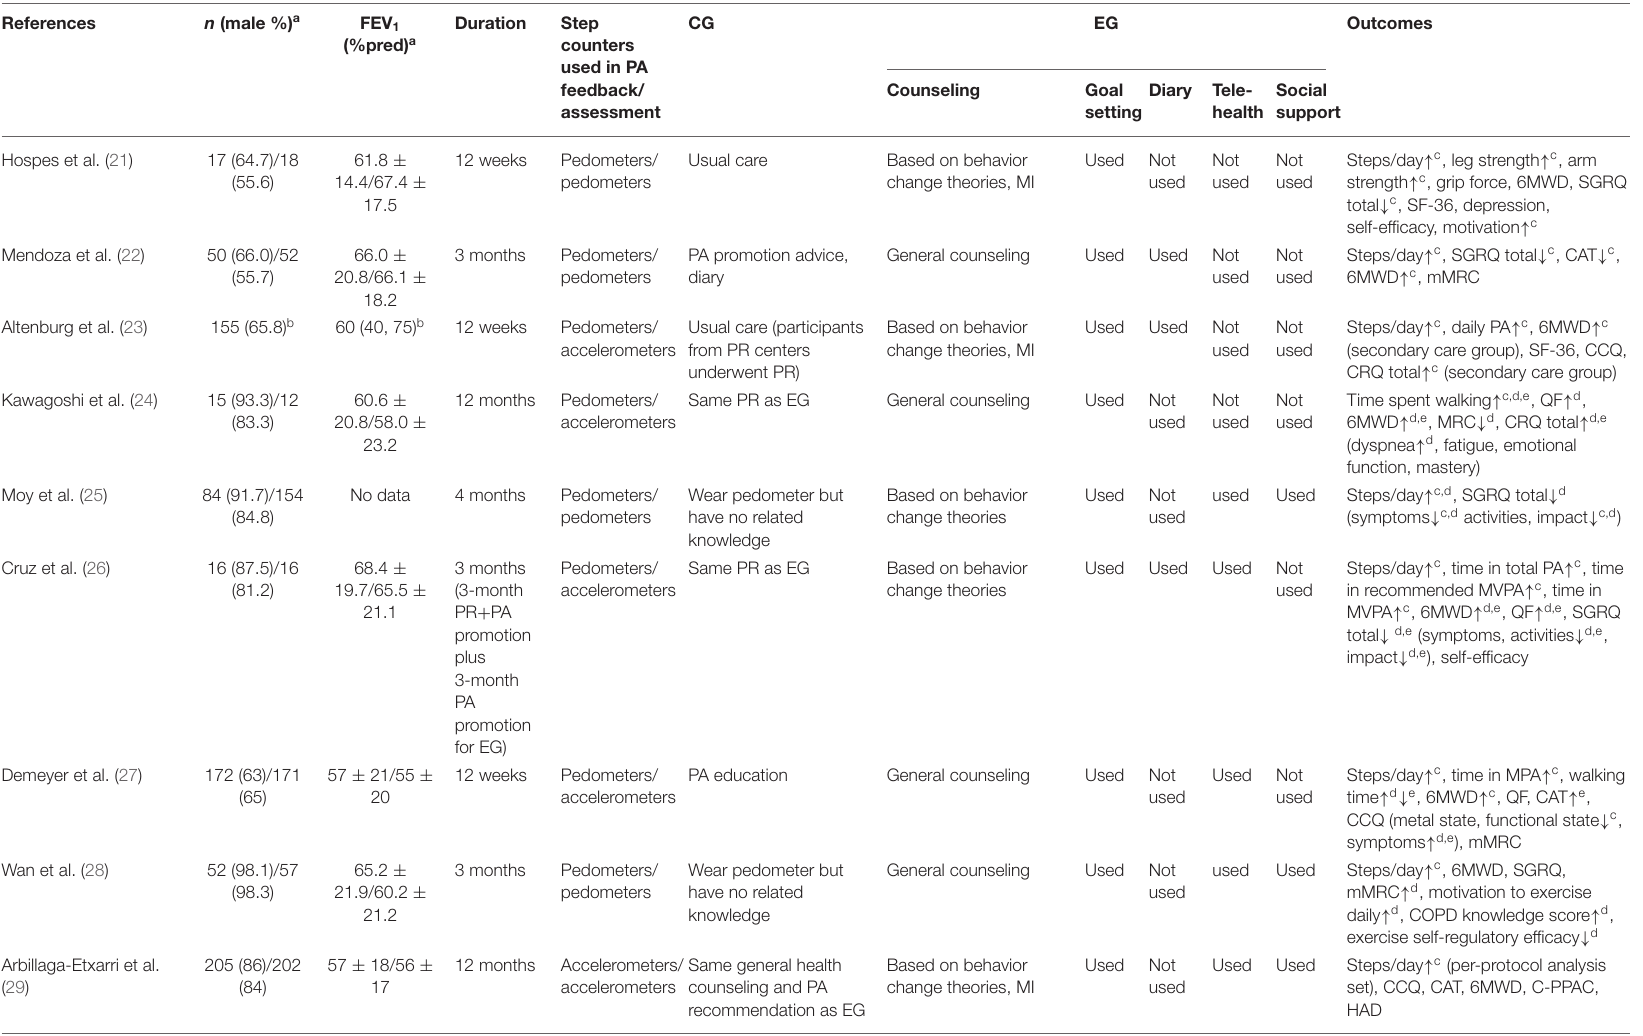
TABLE 1 | Studies about step counter-based PA promotion programs in patients with